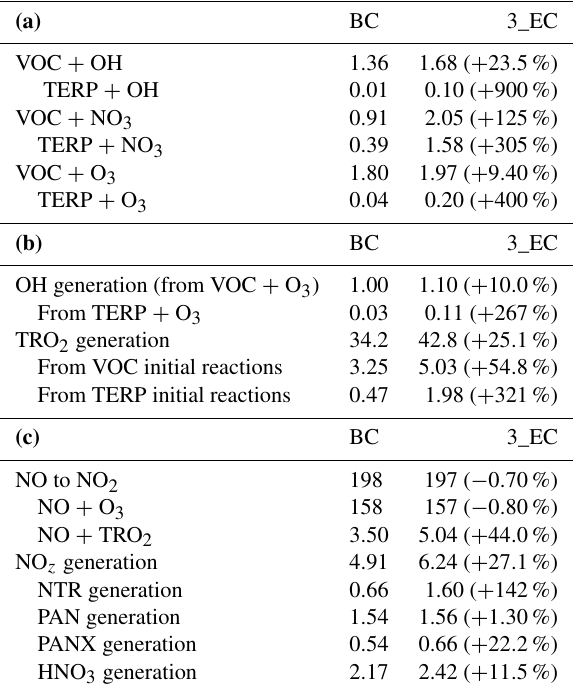
Table 3. All data summed from 27 July, 21:00LST to 28 July, 05:00LST for grid cells and layers shown in Fig. S4. The base case (BC) scenario column shows the absolute predicted values and the subsequent columns show the predicted changes due to emissions from the 3_EC scenario. Percentages in parentheses are the changes in 3_EC relative to BC. Shown is the (a) total amount of VOC and TERP consumed due to oxidation (ppb), the (b) total amount of hydroxyl radical (OH) and total peroxyl radicals (TRO 2 ) that were generated and their sources (ppb), and the (c) total amount of nitro- gen dioxide (NO 2 ) and NO x termination products (NO z ) produced and their sources